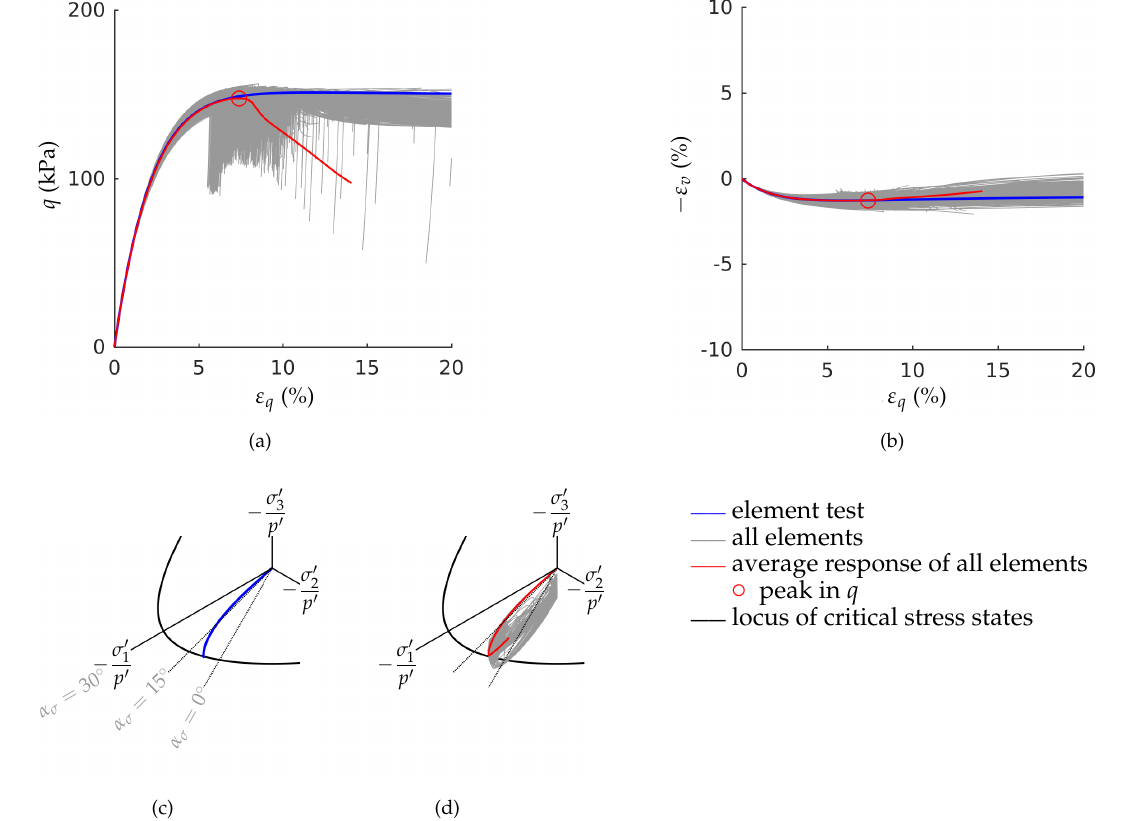
Figure 15. OCR = 3: ( a ) Deviatoric strain ε q -deviatoric stress q plot; ( b ) Deviatoric strain ε q -volumetric strain ε v plot; ( c , d ) Stress paths for OCR = 1.5 in the deviatoric plane normalized with the mean effective stress p (cid:48) .